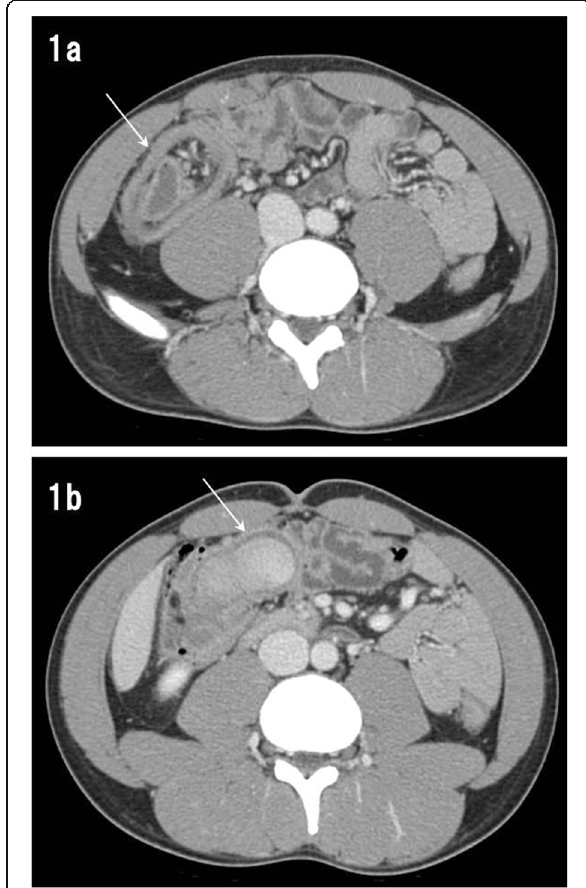
Fig. 1 Abdominal computed tomography. a A characteristic “ target ” sign (white arrow) seen in the right abdomen. b Tumorous mass (white arrow) acting as a leading point for